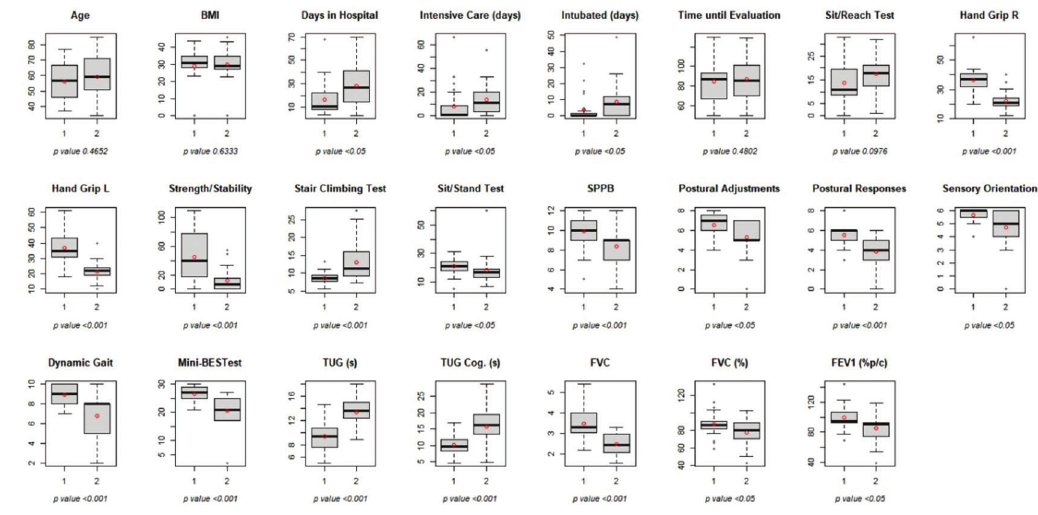
Figure 2 - Box plot of tests by Cluster with indication of means (in red circles) and p -values for the Student ’ s t-test. SPPB, short physical performance battery; BMI, body mass index; D, dominant; ND, no dominant; TUG, Timed Up and Go; TUG-COG, Timed Up and Go Cognitive; FEV1, forced expiratory volume in 1 second; FVC, forced vital capacity.